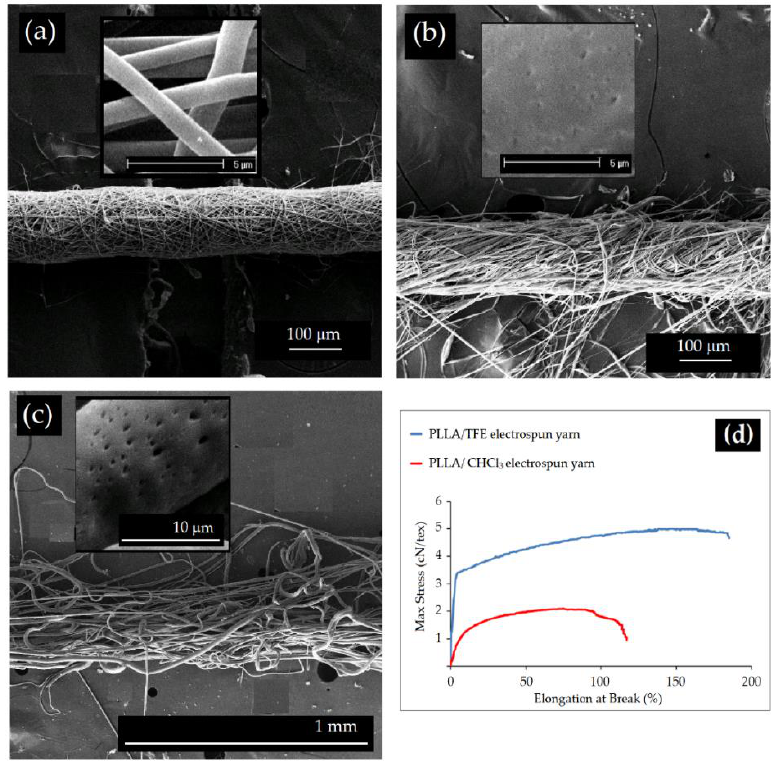
Figure 5. SEM images of electrospun yarn structures from PLA solutions using different solvents; ( a ) TFE (unpublished original picture by the authors), ( b ) DCM (unpublished original picture by the authors), ( c ) CHCl 3 (unpublished original picture by the authors), ( d ) Stress–strain curves of electrospun structures (unpublished original picture by the authors).